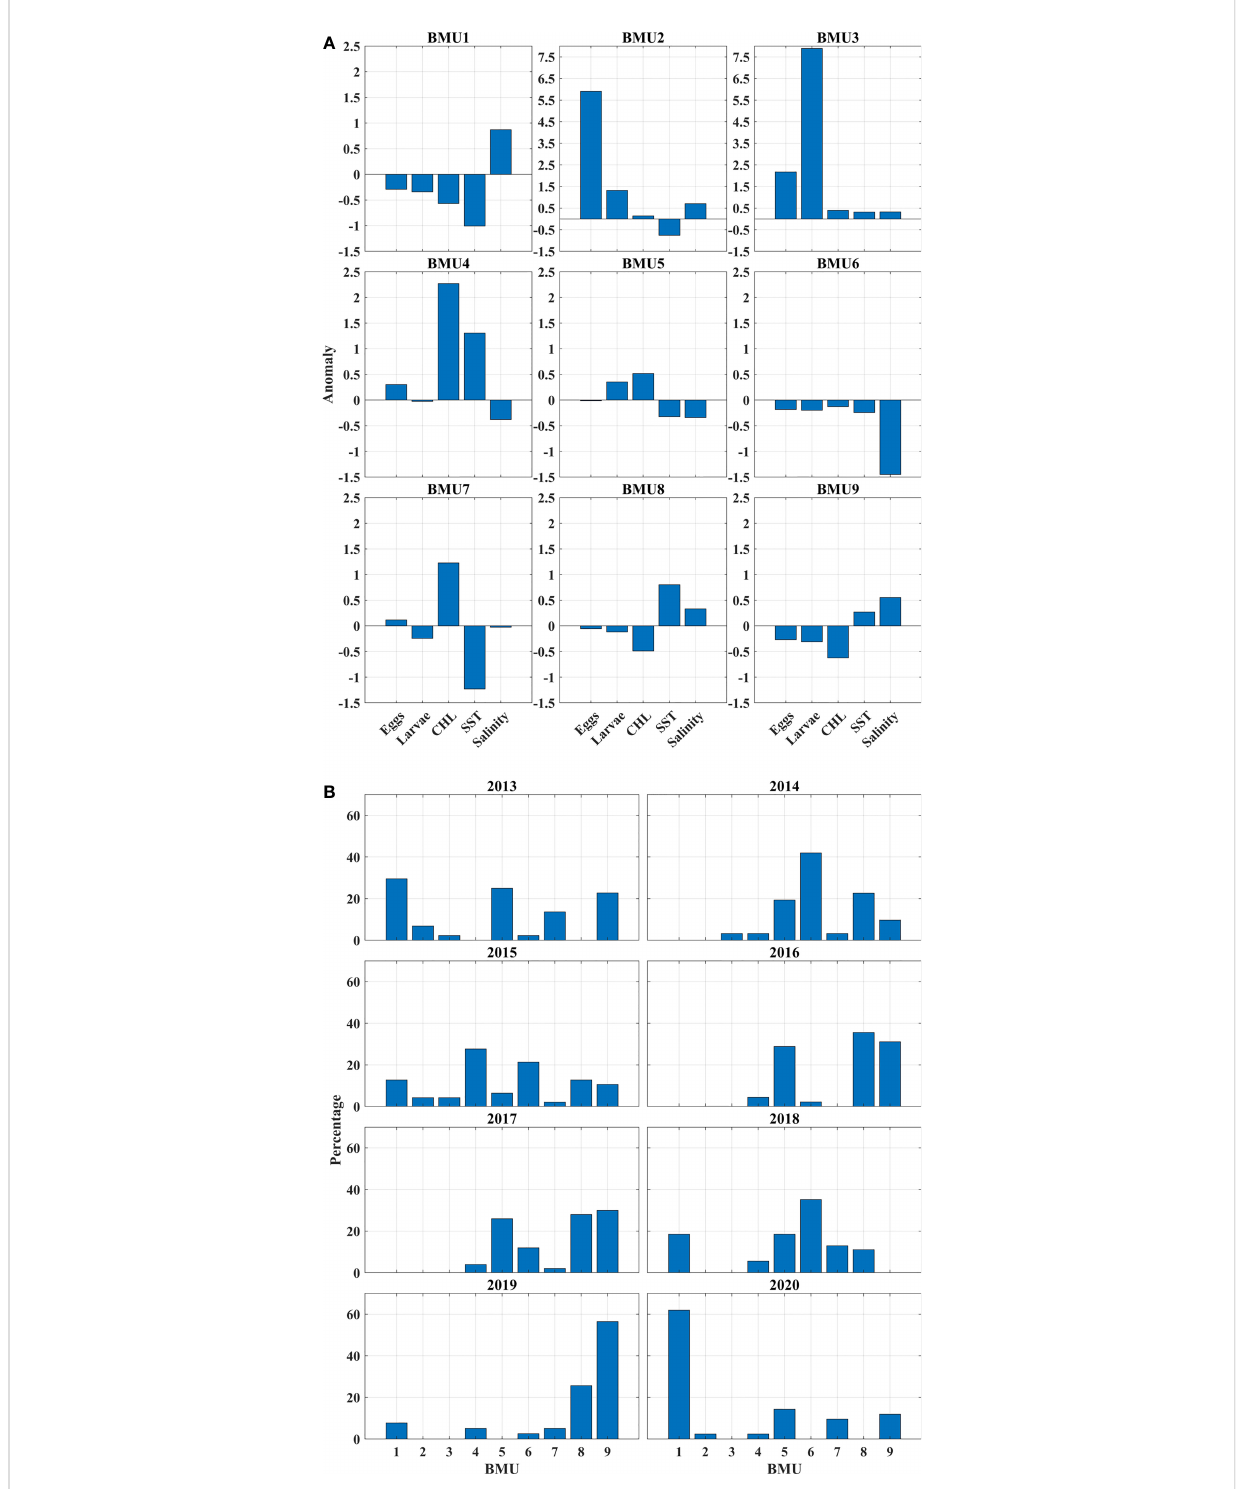
FIGURE 5 (A) Bar chart of Adriatic anchovy egg and larval abundance, environmental (Chl-a) and oceanographic (SST and salinity) variables cataloged in nine best matching units (BMUs) and represented by anomalies. (B) Bar chart of the frequency of occurrence of nine BMUs for each year in the 2013 - 2020 survey